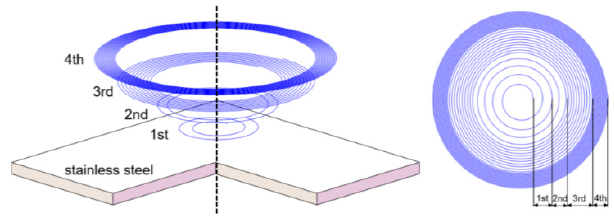
Figure 3. Scanning path of the microhole in femtosecond-laser processing.